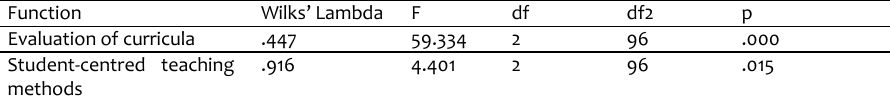
Table 5: Wilks’ Lambda and F-statistics on Equality of Group Means of Factors